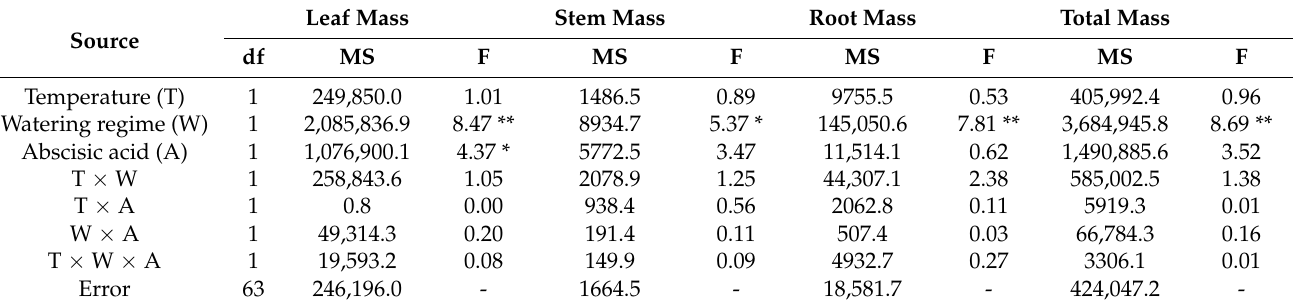
Table 5. Analysis of variance for the effects of temperature, watering regime, abscisic acid, and their interactions on dry mass accumulation of tomato